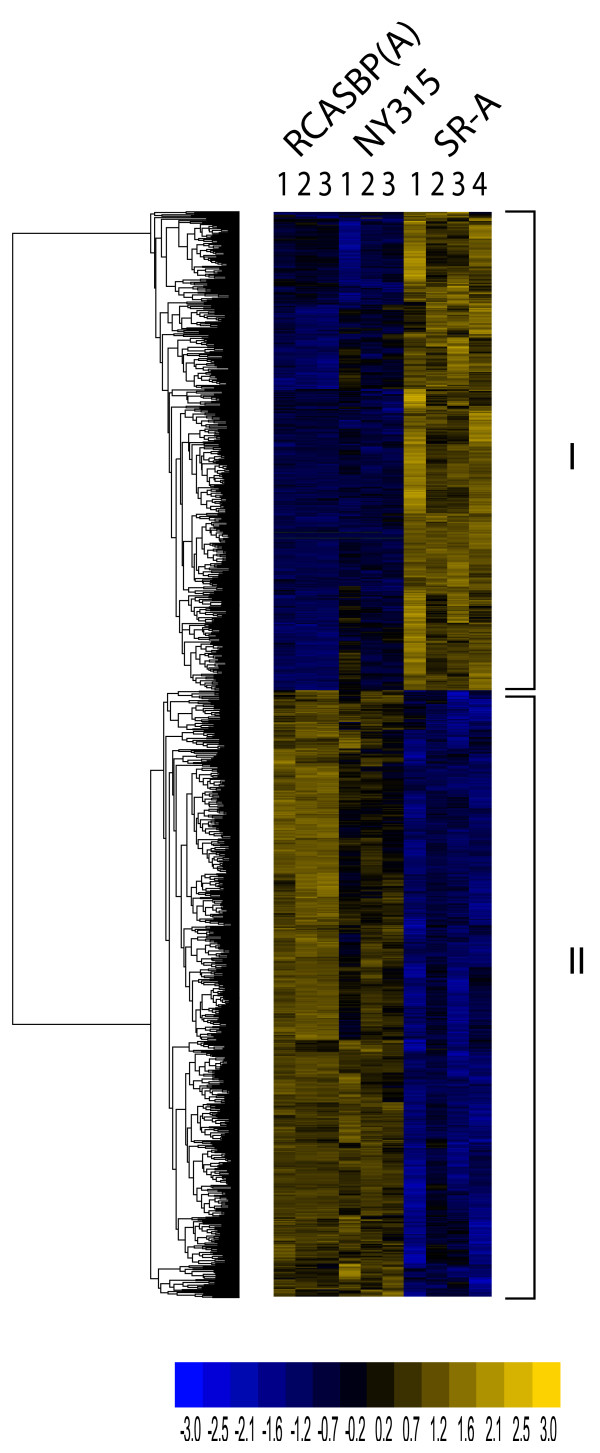
Transformation regulated (TR) genes belong to two clusters of differentially expressed genes in SR-A RSV transformed CEF. Unsupervised hierarchal clustering was performed on the Transformation-Regulated (TR) gene set revealing transformation responsive genes clustering into one of two approximately equal sized clusters. Class I includes genes up-regulated during transformation representing approximately 44% of the TR genes while class II comprises the down-regulated genes (56% TR genes). The color scale indicates standard deviations from mean centered gene expression values.